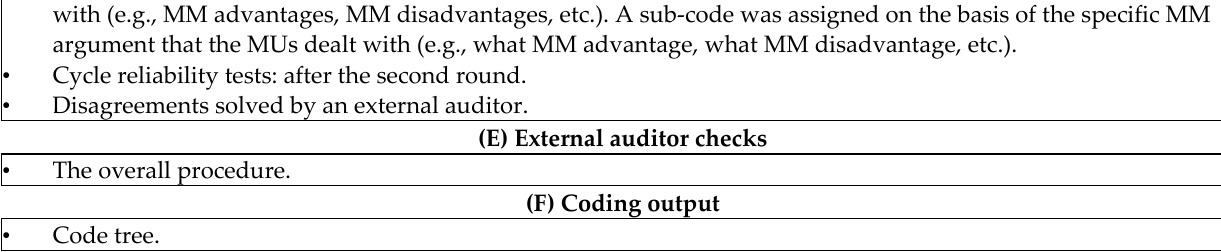
Figure 4. Content analysis process of the examined comments on the GRI 103 Universal Standard.